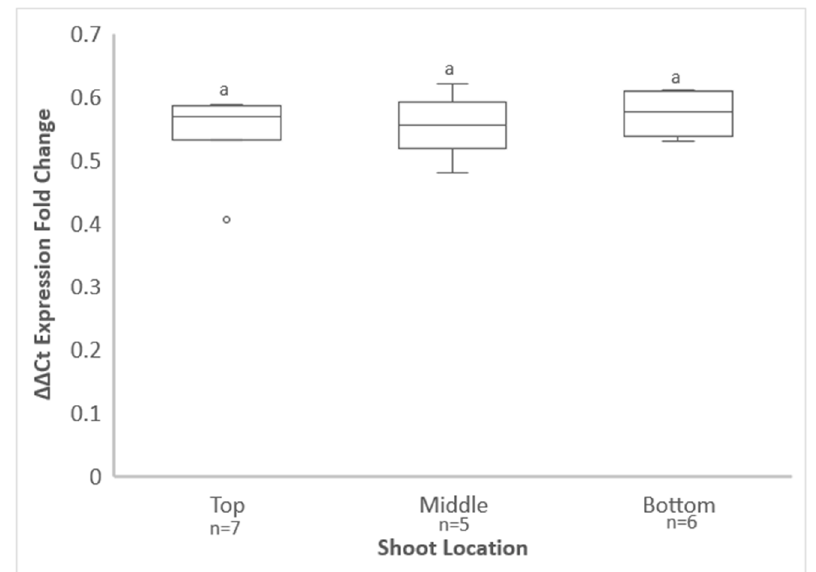
Figure 3. Quantification of grapevine red blotch virus in leaves of the top, middle, and bottom sections of shoots of Vitis californica hybrid vines by qPCR. Data show the ΔΔ Ct expression fold change values (2 ( −ΔΔ Ct) ) from five to seven leaf samples of two vines for each shoot section. Vertical axes are set on logarithmic scales. Error bars indicate standard error of the mean. Lowercase lettering indicating insignificant differences between 2 ( −ΔΔ Ct) values, as determined by Tukey’s honestly significant difference test ( p < 0.05), are shown above standard error bars.